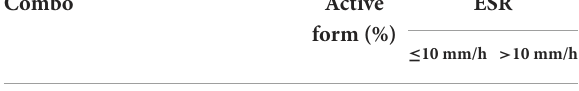
TABLE 3 Number of dogs suffering from a canine leishmaniosis active form according to the combination of C-reactive protein (CRP) and serum ferritin values, and the erythrocyte sedimentation rate (ESR)